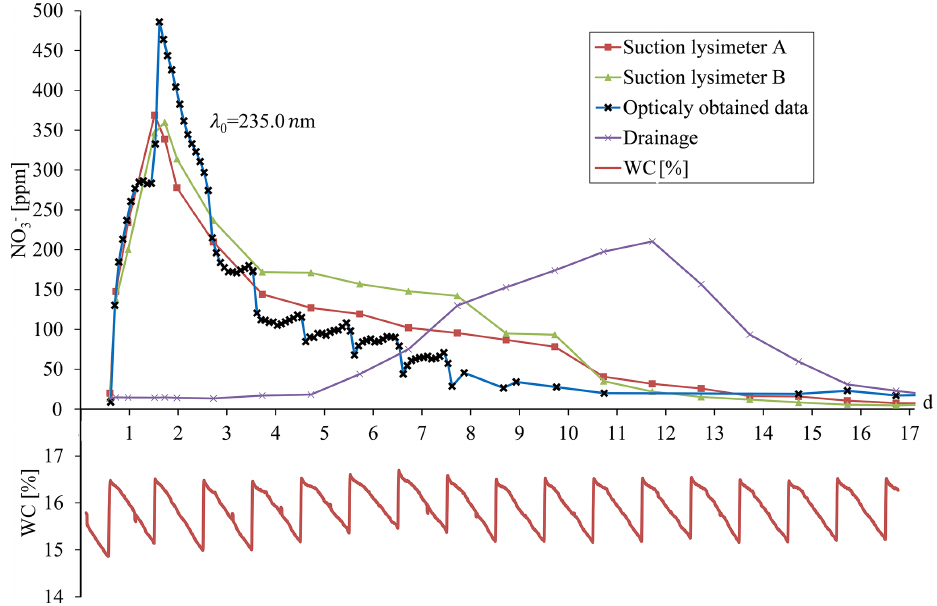
Figure 10. Breakthrough curves plotted for physically sampled solution and calculated nitrate concentration, as obtained automatically by the optical setup. The bottom curve shows the soil water content as obtained by the water-content sensor (TDT).